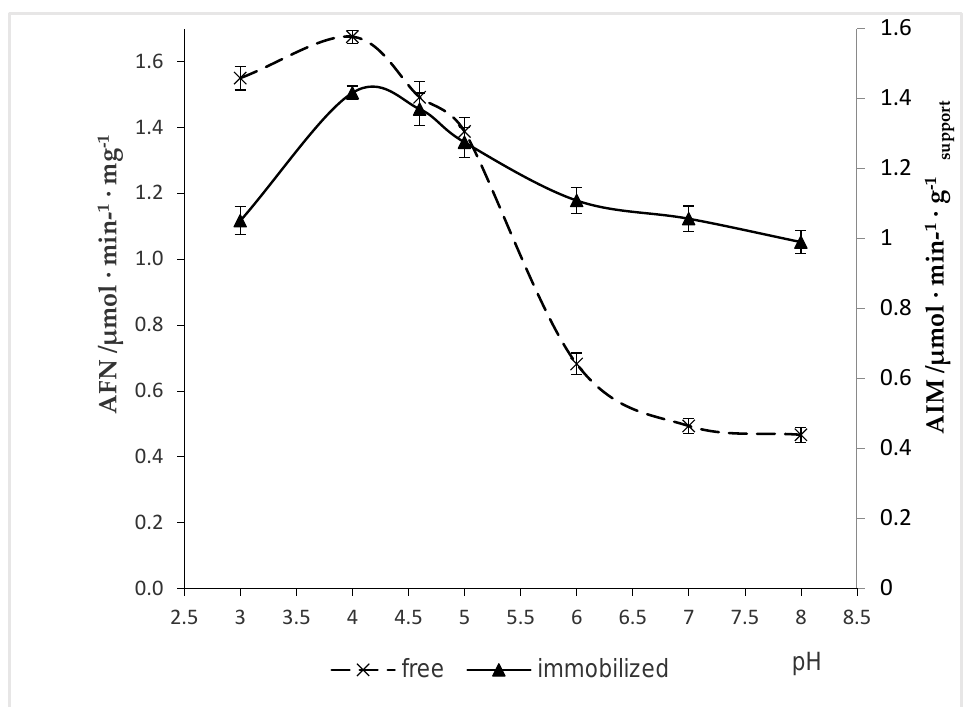
Figure 2. Effect of pH on activity of free and immobilized naringinase. AFN—activity of free naringinase; AIM—activity of immobilized naringinase.